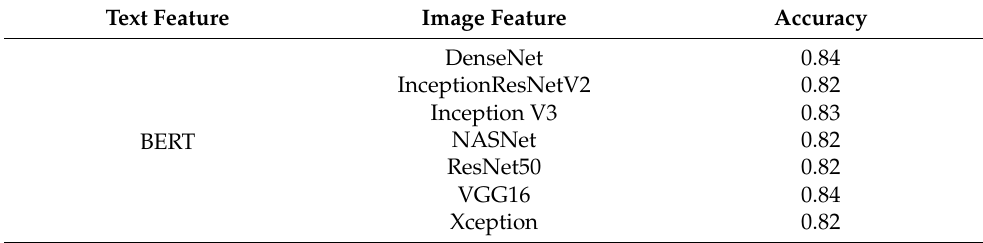
Table 4. Comparison of accuracies between text and image features.